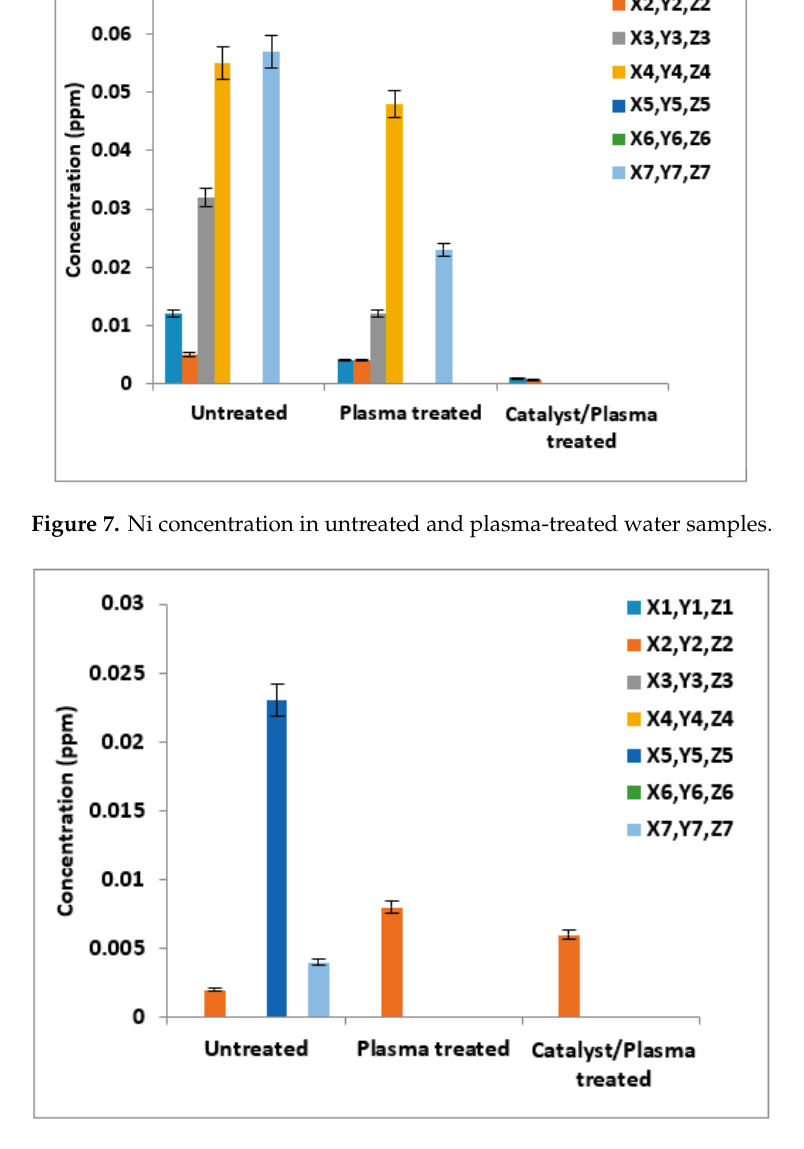
Figure 8. Cd concentration in untreated and plasma-treated water samples.